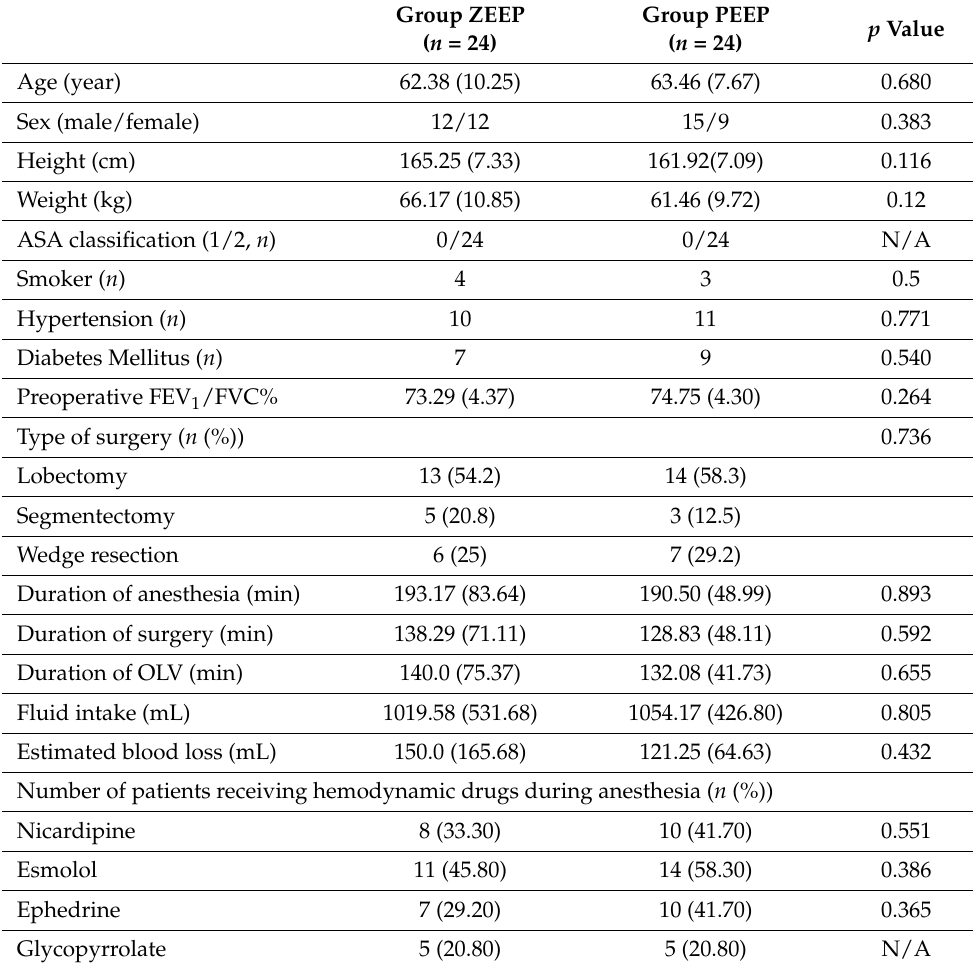
Table 1. Demographic and perioperative data of study groups.